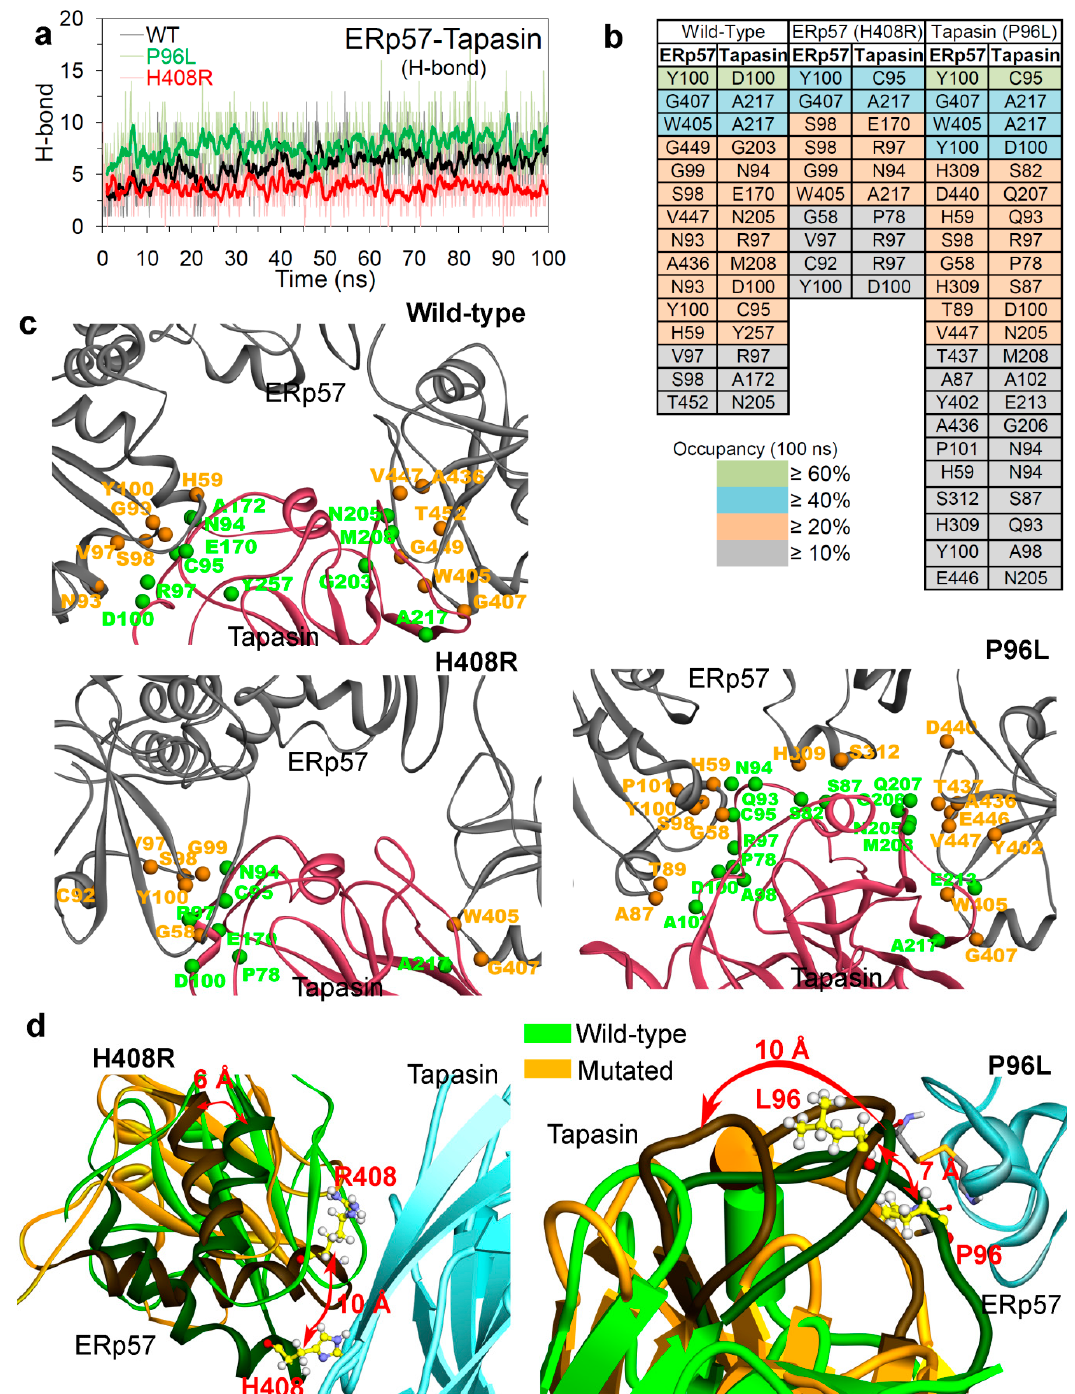
Figure 6. Intermolecular hydrogen bonds formed in the ERp57-tapasin complexes. ( a ) Number of H-bonds formed between ERp57 and tapasin over 100 ns of MD simulations. ( b and c ) Functional residues of ERp57-tapasin involved in H-bond formation. In the diagram, interacting pairs of residues are coloured according to their H-bond occupancy over 100 ns of MD simulation. ( d ) Inward conformation change of mutation H408R (reduces ERp57-tapasin interactions) and outward conformation of P96L mutant (increases ERp57-tapasin interactions). Colour scheme: carbon in yellow, oxygen in red, hydrogen in silver, nitrogen in blue, and sulphur in orange.